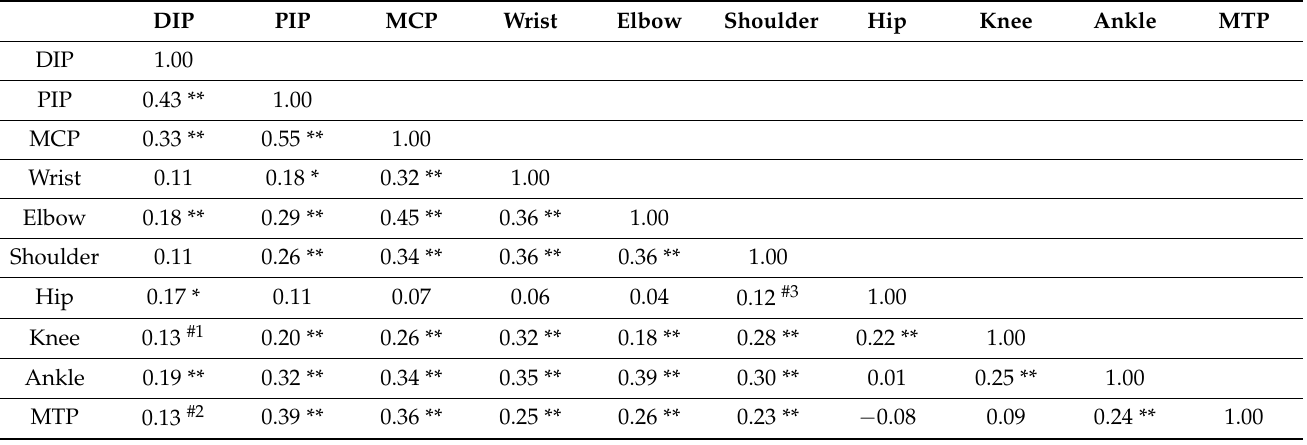
Table 4. Correlation coefficients among the numbers of affected distal interphalangeal (DIP) and non-DIP joints in patients with rheumatoid arthritis (RA) exhibiting DIP joint